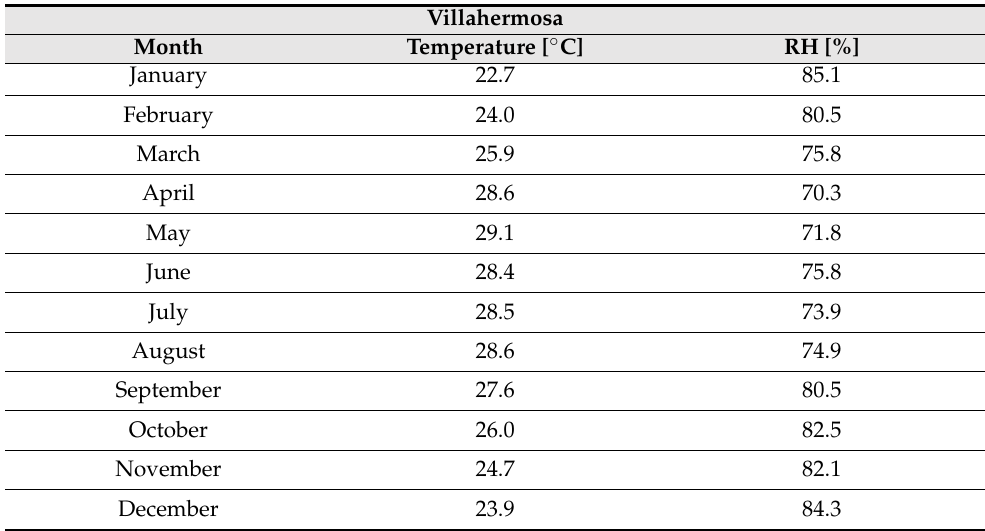
Table 9. Average weather data in Villahermosa.